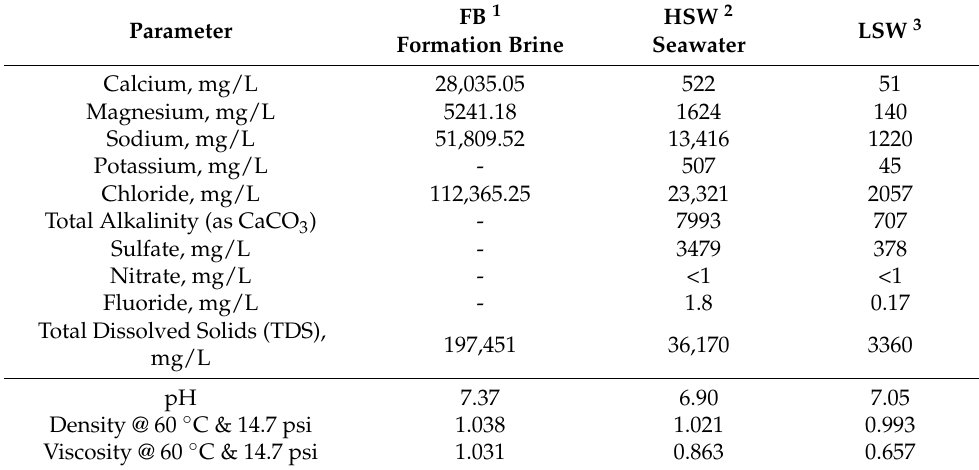
Table 3. Composition of brine [96].